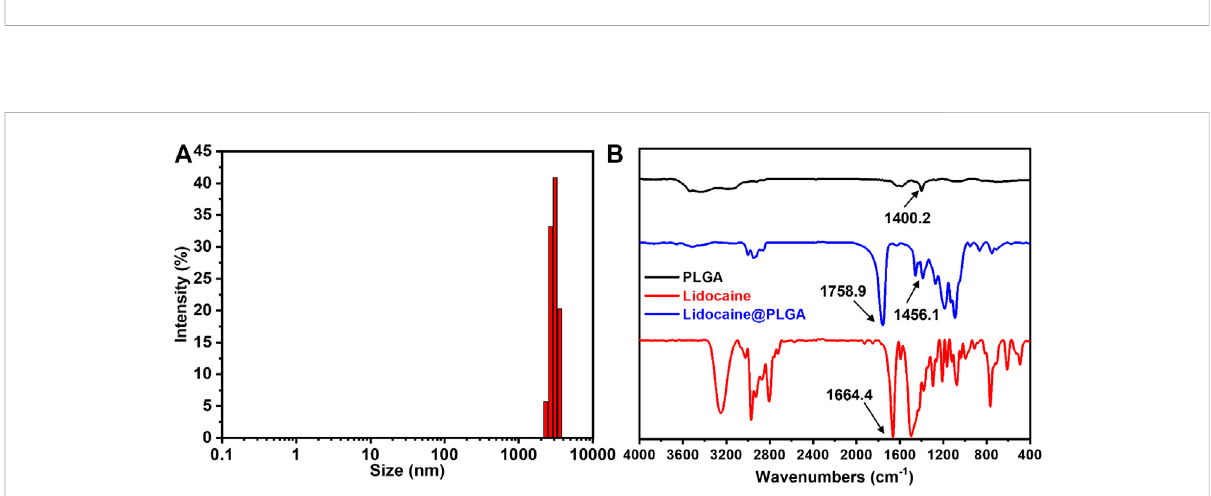
FIGURE 4 (A) DLS pro fi le of the Lidocaine@PLGA microcapsule. (B) IR spectra of the drug, PLGA polymer, and the Lidocaine@PLGA